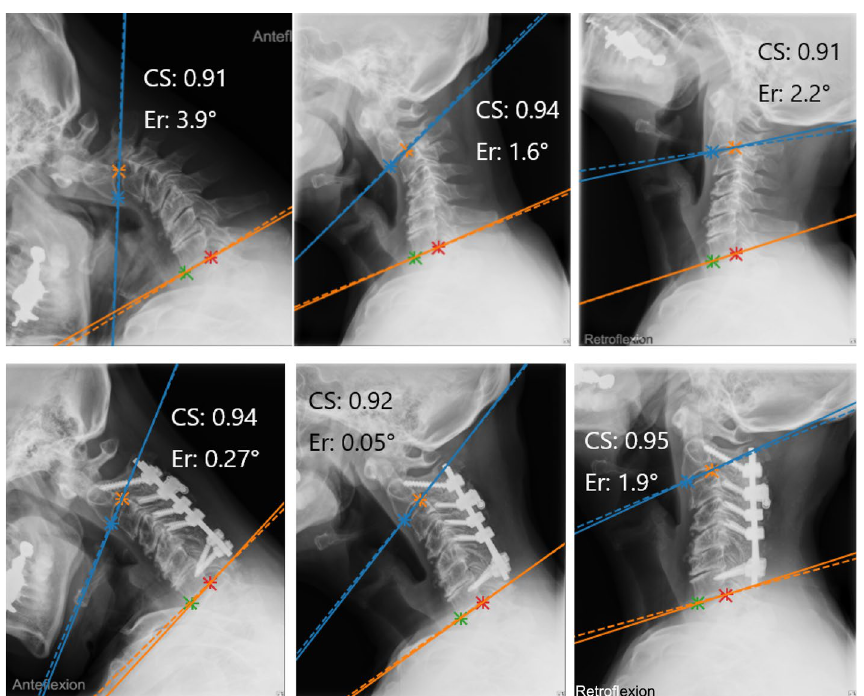
Figure 4. Preoperative (upper) and postoperative (lower) x-rays of a 54-year-old man. The solid lines represent the ground truth, and the dashed lines represent the measurement obtained by artificial intelligence. CS, confidence score; Er,